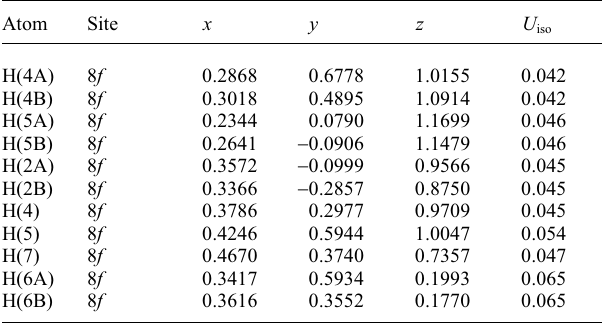
Table 2. Atomic coordinates and displacement parameters (in Å 2 )